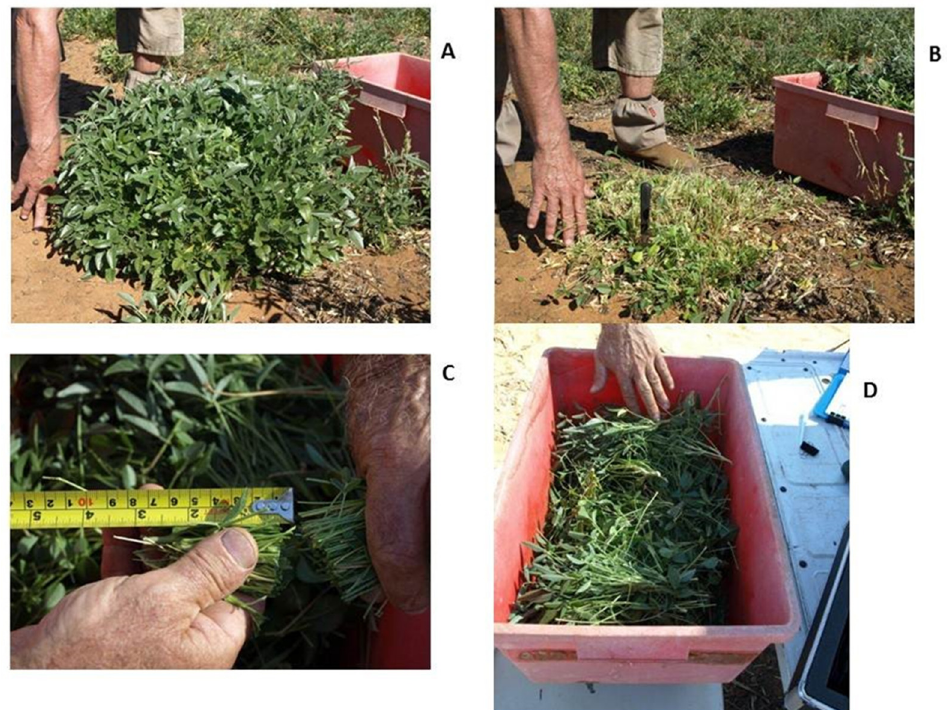
Figure 3. ( A ) 800 g of fresh tedera from a single plant before harvesting; ( B ) the same tedera plant following harvesting; ( C ) harvesting length (50–70 mm); and ( D ) fresh tedera sample.